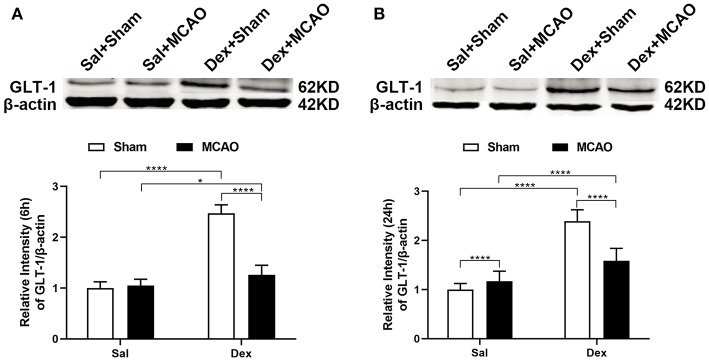
Dexmedetomidine upregulated GLT-1 expression in rat brains. Western blotting analysis of GLT-1 expression at 6 h (A) and 24 h (B) following rat MCAO. Dexmedetomidine significantly upregulated GLT-1 expression in Sham group at 6 h (t = 23.38, p < 0.0001) and 24 h (t = 16.35, p < 0.0001), and in MCAO group at 6 h (t = 3.338, p = 0.0103), and 24 h (t = 4.921, p < 0.0001) in rat brains. Data are expressed as mean ± SD (n = 10 animals per group). *p < 0.05, ****p < 0.0001 (two-way ANOVA followed by the Bonferroni multiple comparisons test).